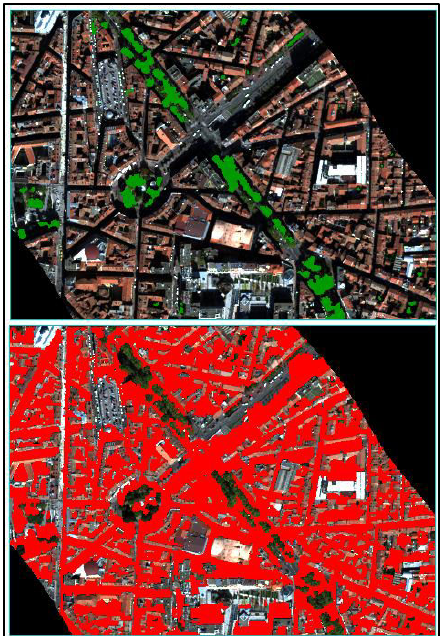
Figure 6. Vegetation (green) and roads (red) classes identified by textural